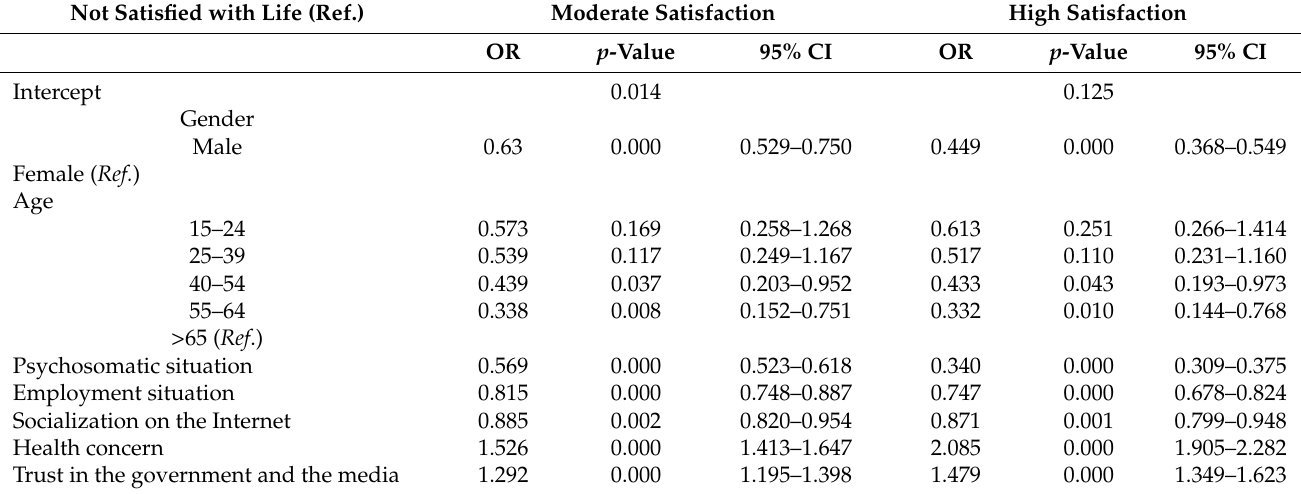
Table 2. Multinomial logistic regression models predicting satisfaction with life during lockdown, based on demographic and social factors. Not Satisfied with Life